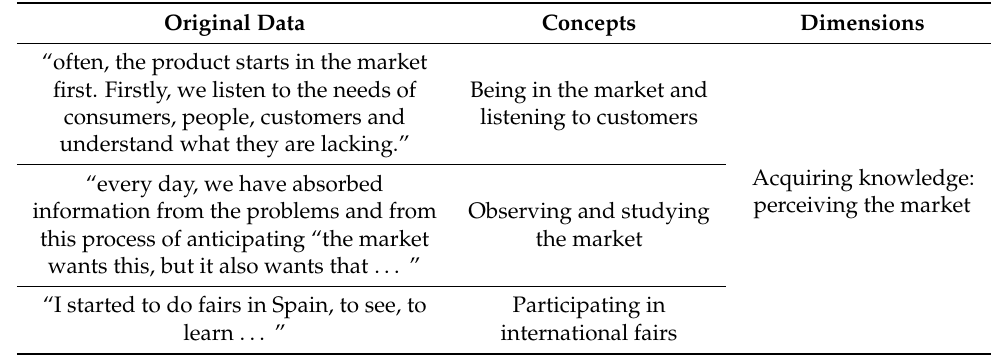
Table 2. Open coding